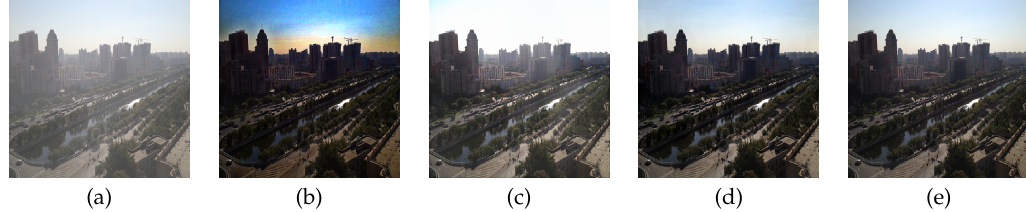
Figure 1. Comparison between the proposed method and the atmospheric scattering model-based methods: ( a ) input image, ( b ) DCP [9], ( c ) DCPDN [17], ( d ) the proposed method, and ( e ) the clean